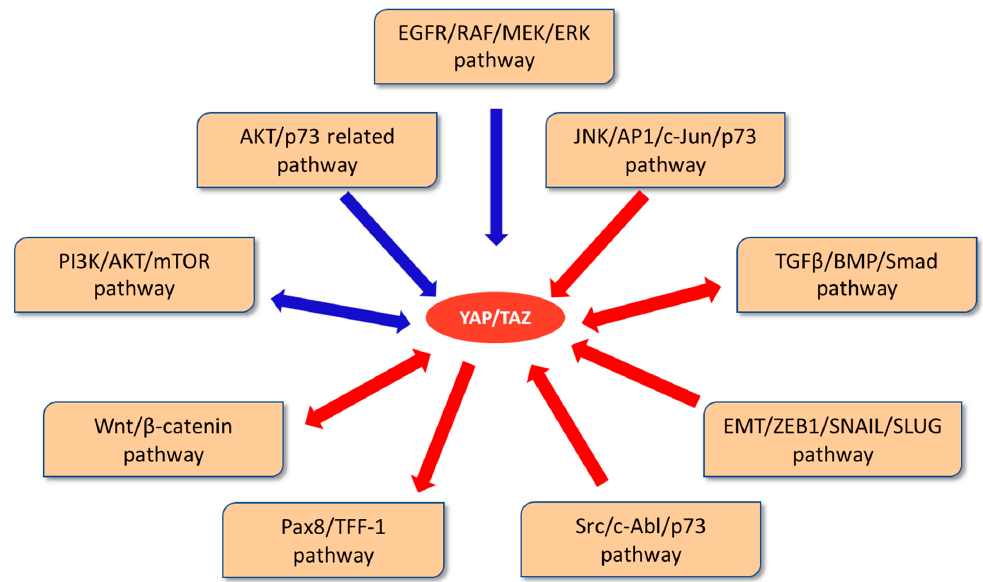
Figure 2. Crosstalk of YAP/TAZ with other signalling pathways than Hippo signalisation. YAP/TAZ negative regulation is represented by the blue arrows and positive regulation by the red ones.